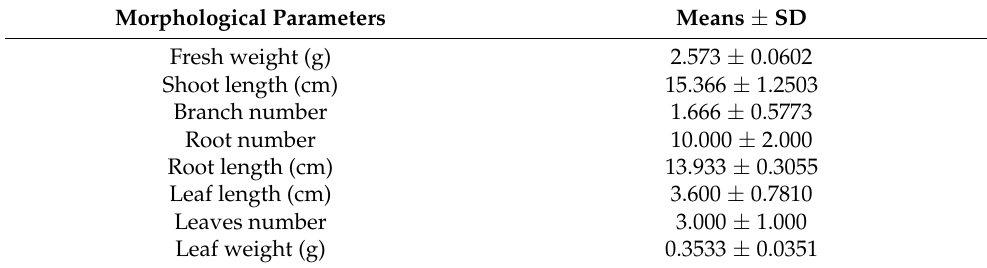
Table 1. Means of morphological measurements of Zantedeschia after four weeks grown on MS in vitro culture.